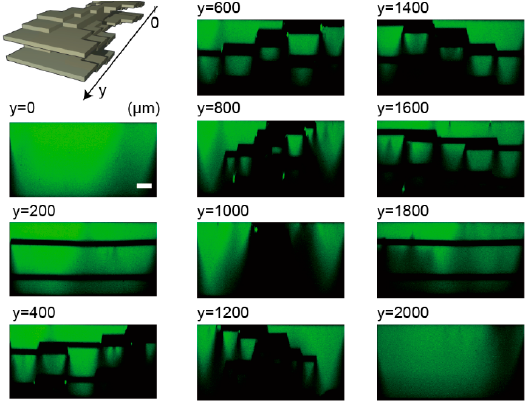
Figure 5. Confocal microscope images of a ten-layer spiral structure at every 200 µm in the flow direction of the microchannel. Scale bar is 100 µm.